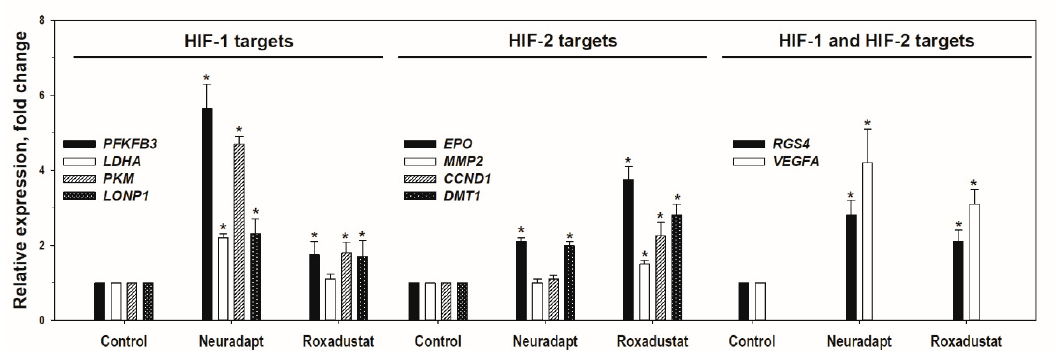
Figure 4. Relative expression of HIF target genes upon 5 h incubation of neuroblastoma SH-SY5Y cells with 10 µ M neuradapt and 30 µ M roxadustat, * p < 0.05.